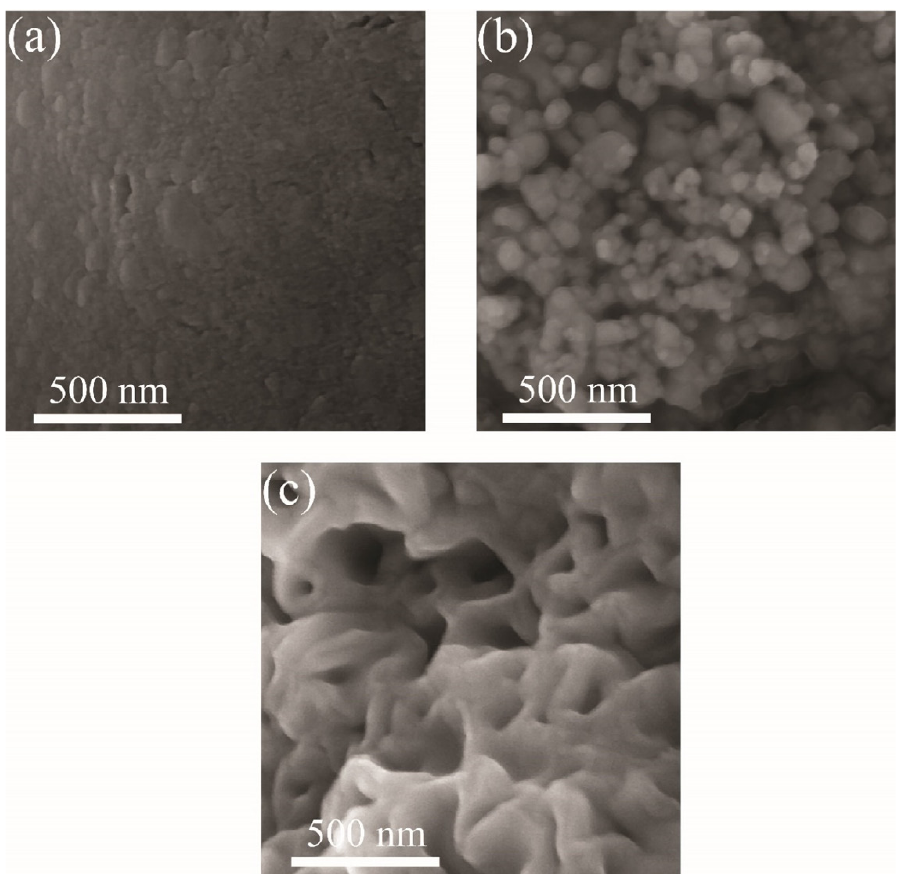
Fig. 2. FESEM images of the NiO nanostructures synthesized at a) 400 °C , b) 600 °C , and c) 700